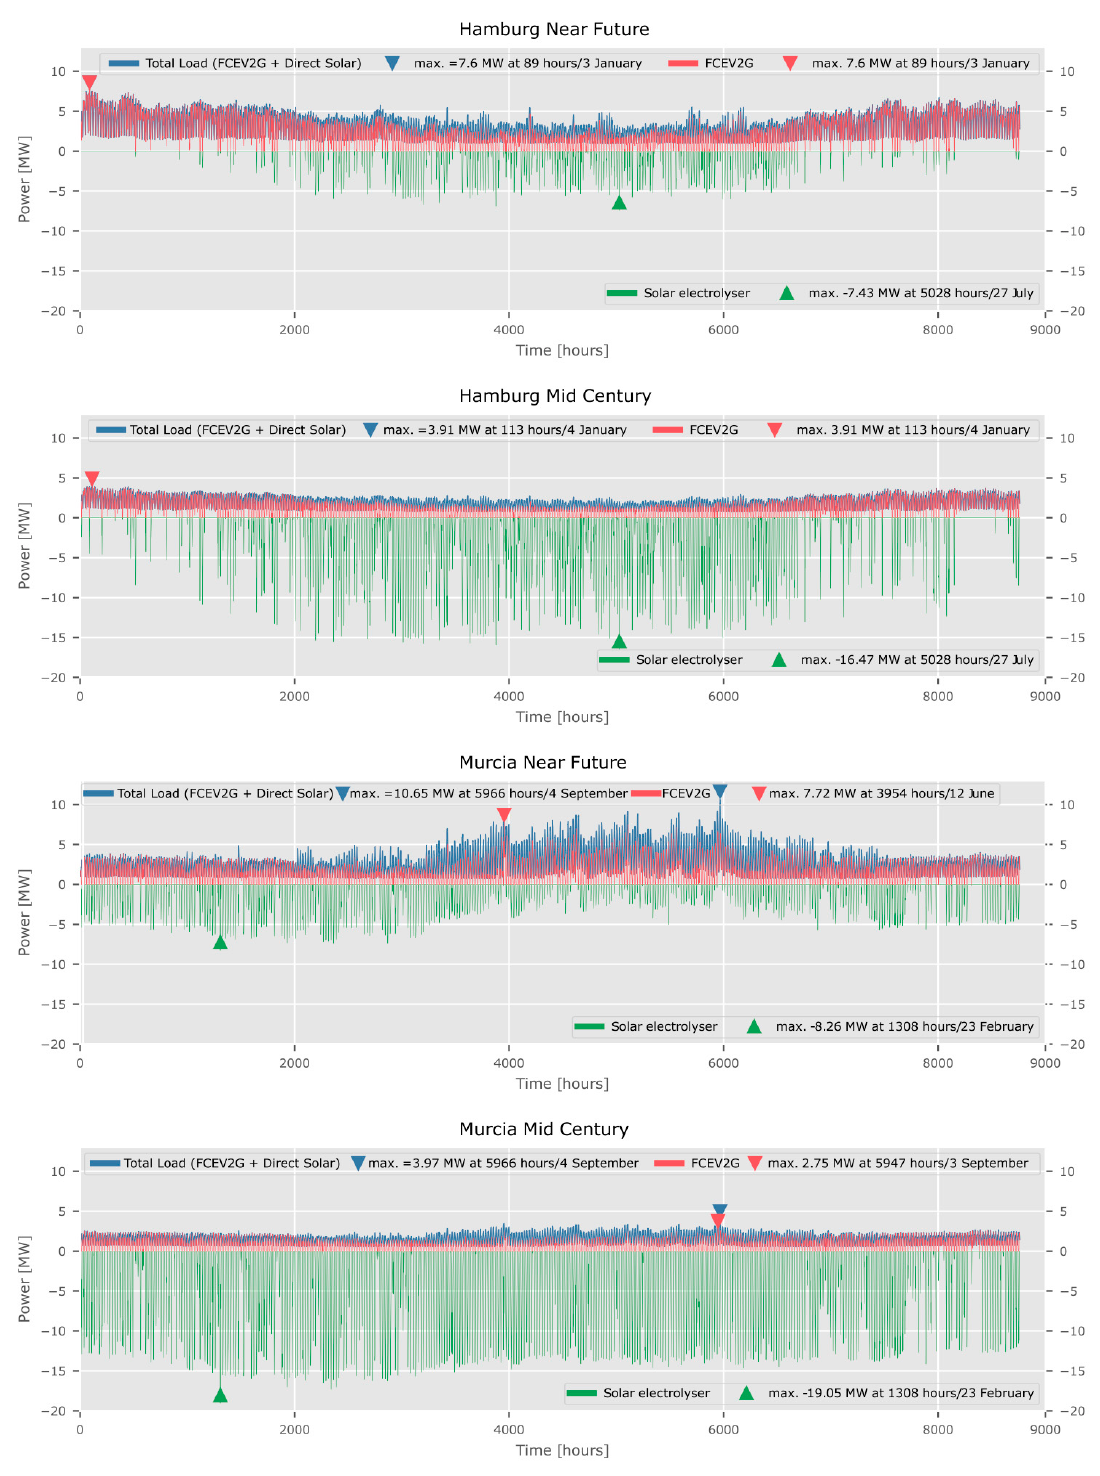
Figure A2. Hourly electricity balances for an entire year based on 2016 weather data. From top to bottom, Hamburg in the Near Future and Mid Century and Murcia in the Near Future and Mid Century.